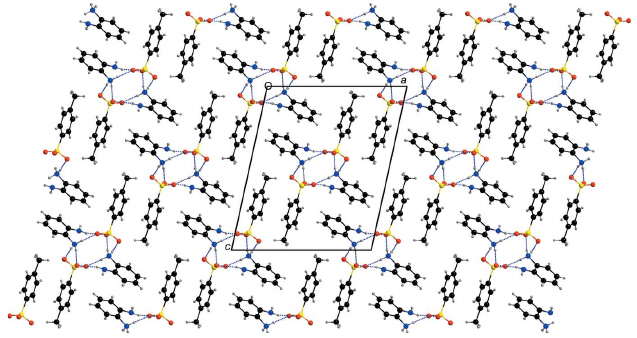
Figure 2 The hydrogen-bonding scheme around the 4-methylbenzene-1-sulfonate anion. Symmetry codes: (i) -x + 1, (cid:3) y , (cid:3) z + 1; (ii) (cid:3) x + 1, (cid:3) y + 1, (cid:3) z + 1.